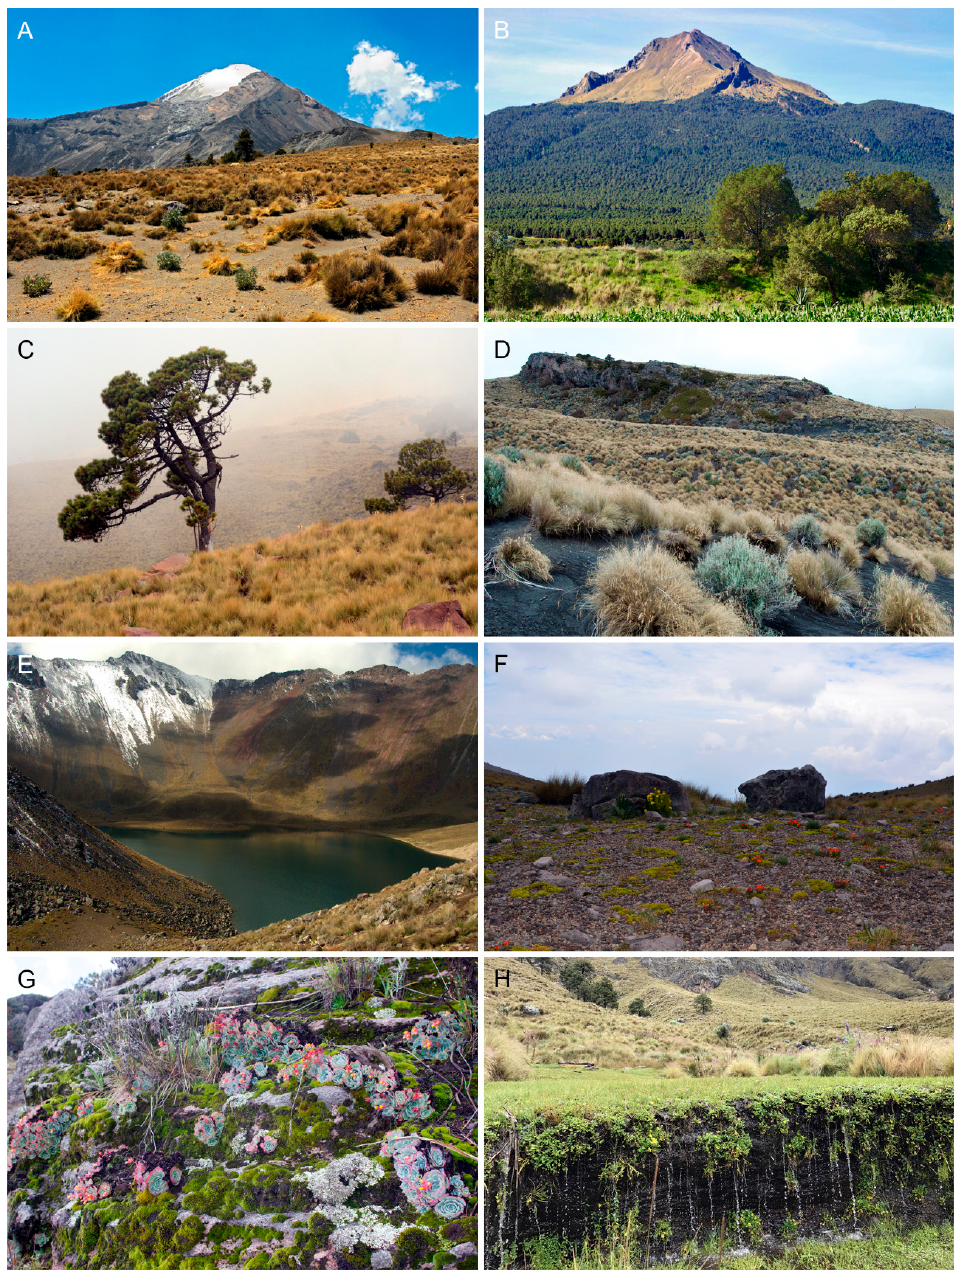
Figure 2. Alpine vegetation of central Mexico. ( A ) North side of the Pico de Orizaba; ( B ) La Malinche from a distance; ( C ) Nevado de Toluca; ( D ) north side of Popocátepetl; ( E , F ) Nevado de Toluca; ( G ) rocky outcrop covered with Echeveria secunda on Tláloc; ( H ) seep on Iztaccíhuatl. Credits: ( A , E , F , H ) Victor Steinmann; ( B , D , G ) Adolfo López; ( C ) Libertad Ar- redondo.